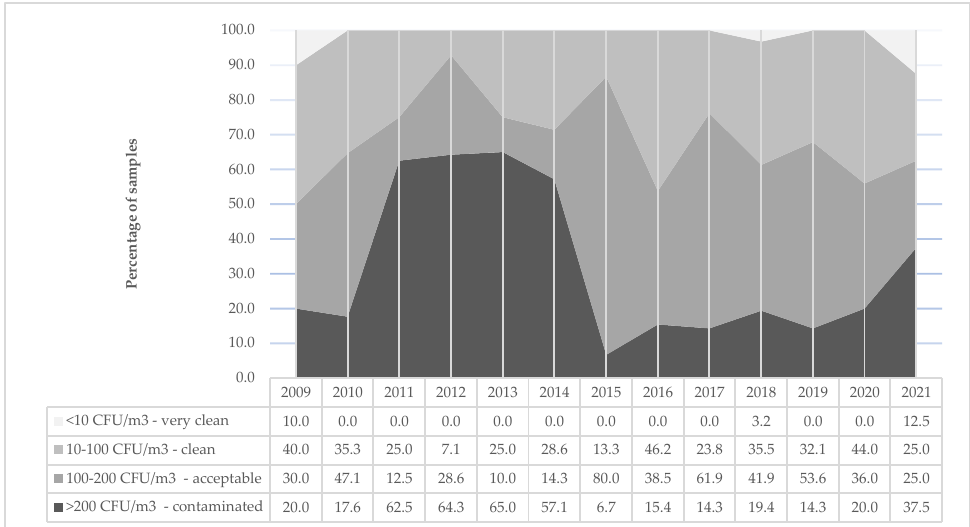
Figure 1. Distribution (%) of air samples by level of contamination over years (2009–2021). Table 3. Temporal trend of contaminated air samples in each ICUs.